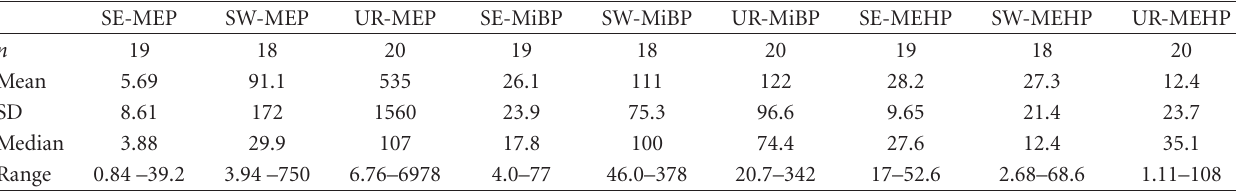
Table 7: Urinary phthalate metabolite levels in the general pop- ulation ( μ g/g) (national health and nutrition examination survey (NHANES) data) [3, 9]. Above detection Geometric limit (%)